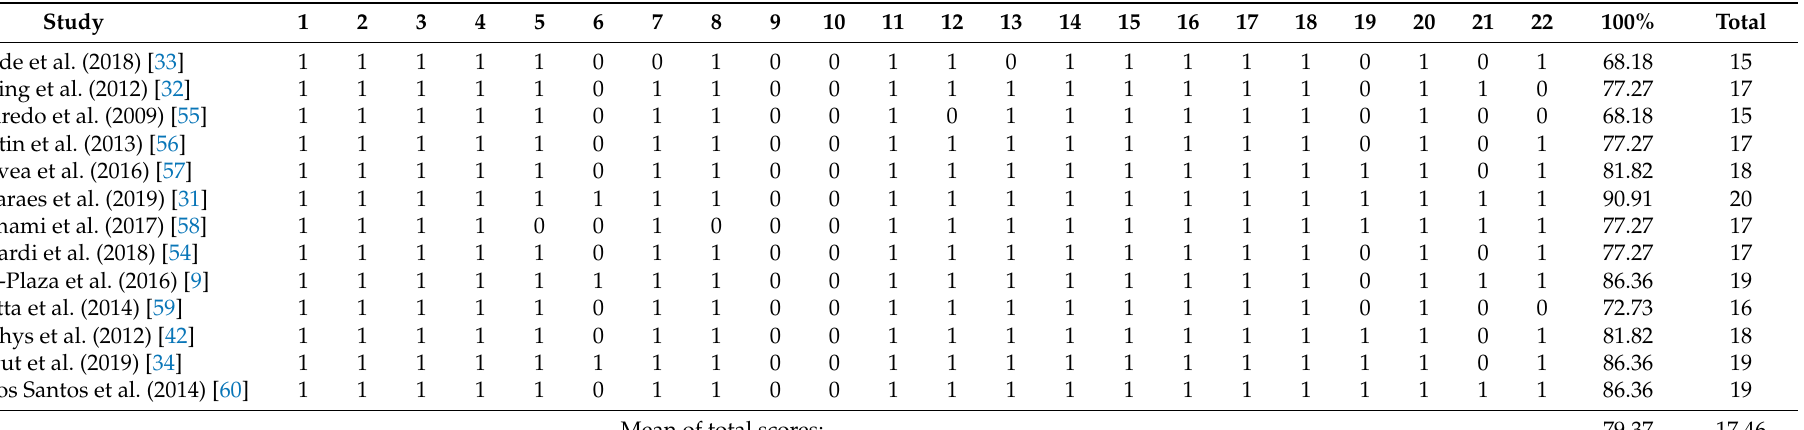
Table 2. Quality assessment of the selected